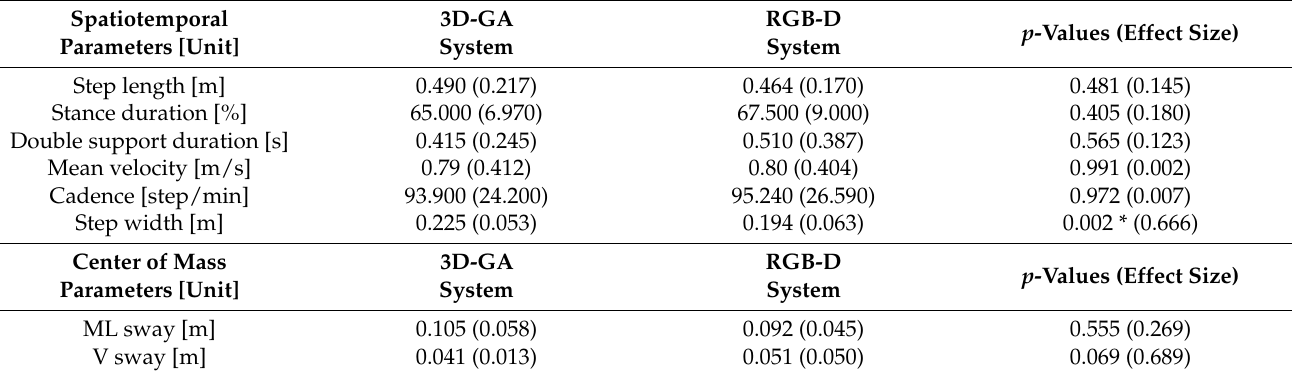
Table 2. Results of the statistical analysis on the median and first quartile values for spatiotemporal and COM parameters estimated for the two systems. Only step width shows a significant difference.